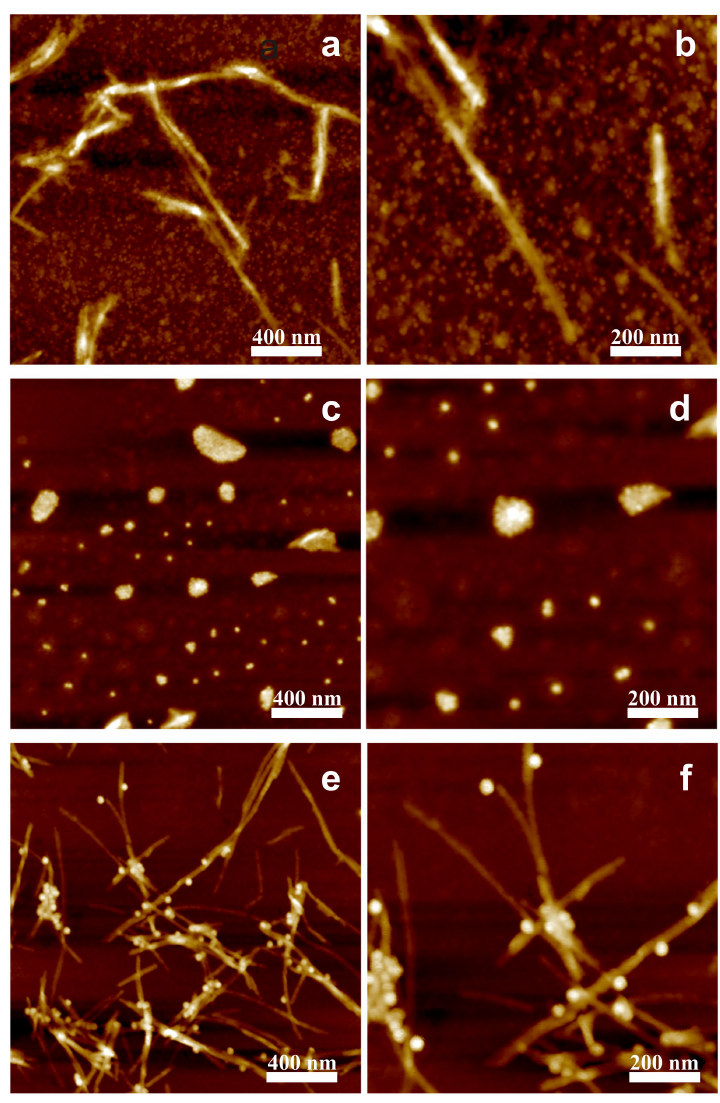
Figure 3. AFM images of LAF doped with MNPs of diameter sizes of ( a , b ) 5 nm, ( c , d ) 10 nm, and ( e , f ) 20 nm. All right-hand panels are magnification of that on the